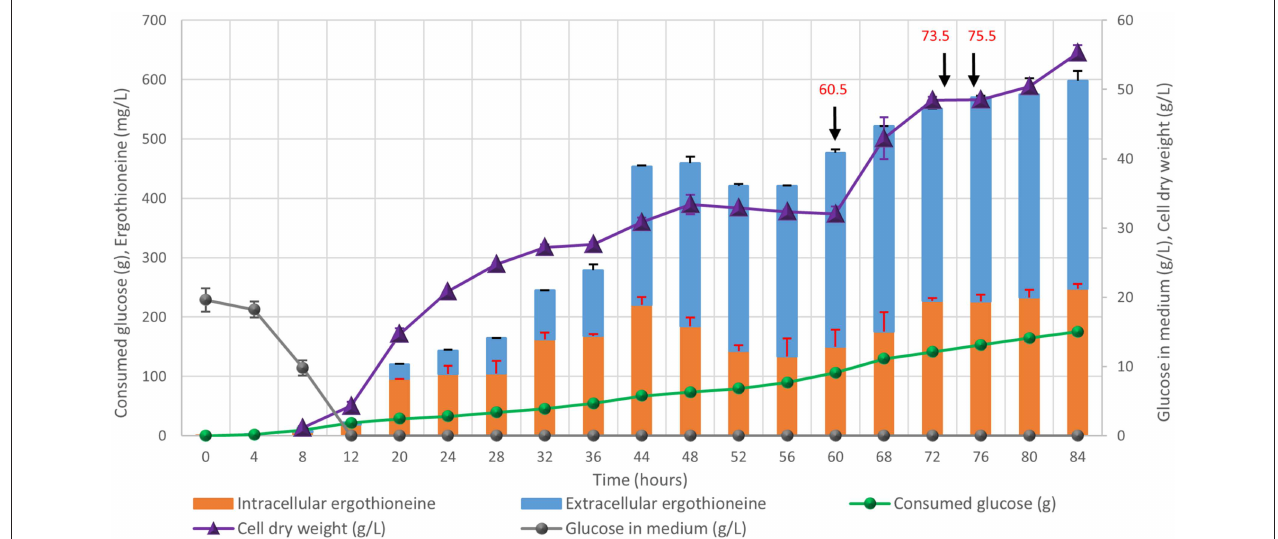
FIGURE 8 | Fed-batch cultivation of ERG-producing strain ST8927. The cultivations were performed in duplicate, the average values are shown. The error bars show standard deviations. The additions of minerals, trace metals, and/or vitamins are indicated by black arrows. At 60.5h, we added 2g (NH 4 ) 2 SO 4 , 0.5g MgSO 4 , 4ml trace metals solution, and 2ml vitamin solution, at 73.5h we added 0.5g MgSO 4 , 4ml trace metals solution 2ml vitamin solution and at 75.5h we added 2g (NH 4 ) 2 SO 4 . At 60.5 and 75.5h, 2g (NH 4 ) 2 SO 4 was added as a sterile 100 g/l solution. At 60.5 and 73.5h, 0.5g MgSO 4 was added as a sterile 50 g/l solution, while 4ml sterile trace metals solution and 2ml sterile vitamin solution were